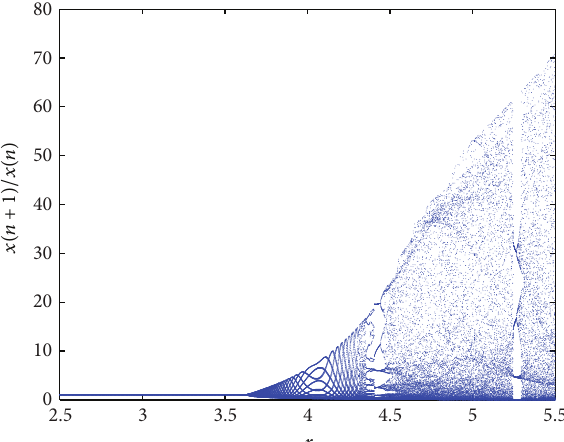
Figure 2: Behavior of the solutions of (68), where 𝛼 = 0.00195789 , = 0.00196 , 𝛽 = 0.00392 , 𝛿 = 0.0125 , 𝛿 = 0.00125 , and 𝐸 = 0.4 . 𝛽 1 0 1 2